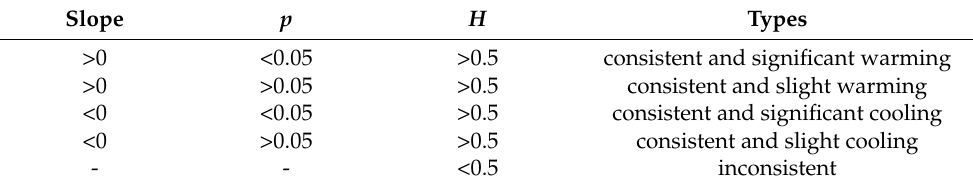
Table 2. Five criteria for dividing the superposition information of trend results and Hurst